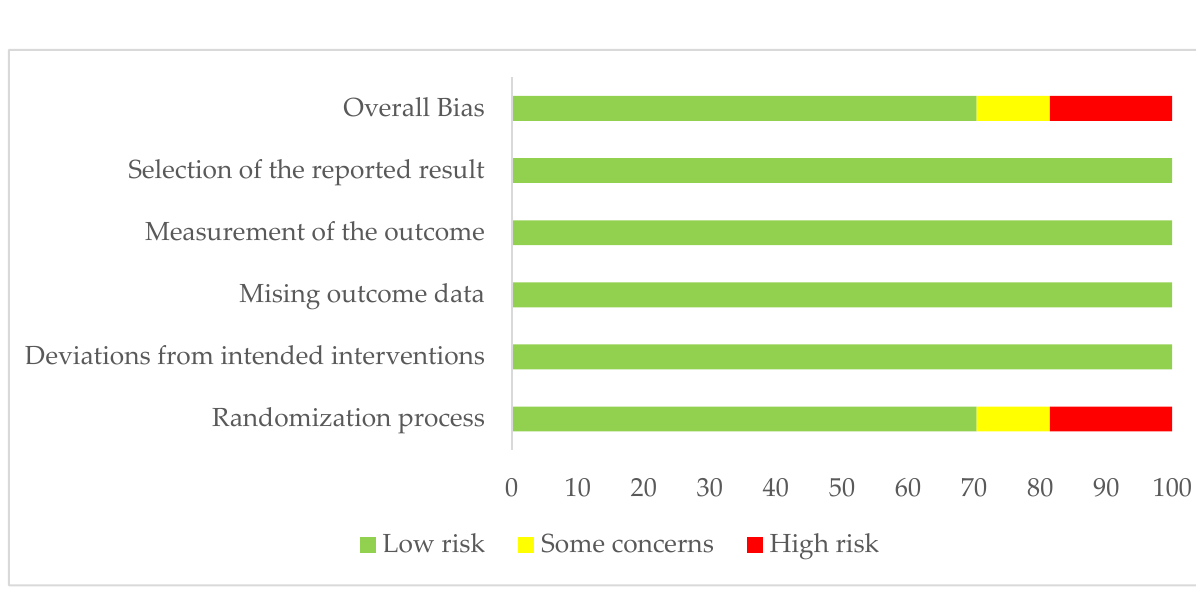
Figure 2. Risk of bias of included studies. Table 3. Results from